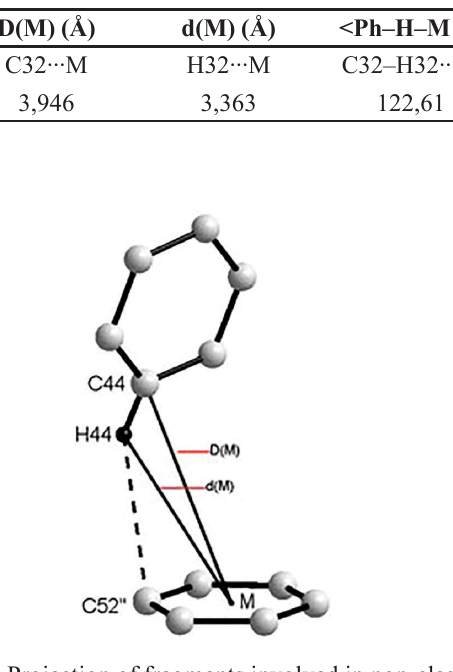
FIGURE 5 - Projection of fragments involved in non-classical aromatic hydrogen bonding C-H ∙∙∙ Ph on C41-C46 / C51' - C56' complex. [Symmetry Codes (''): -1 + x, y, z]. Hydrogen atoms are omitted for better layout view. M = centroid point of the aromatic